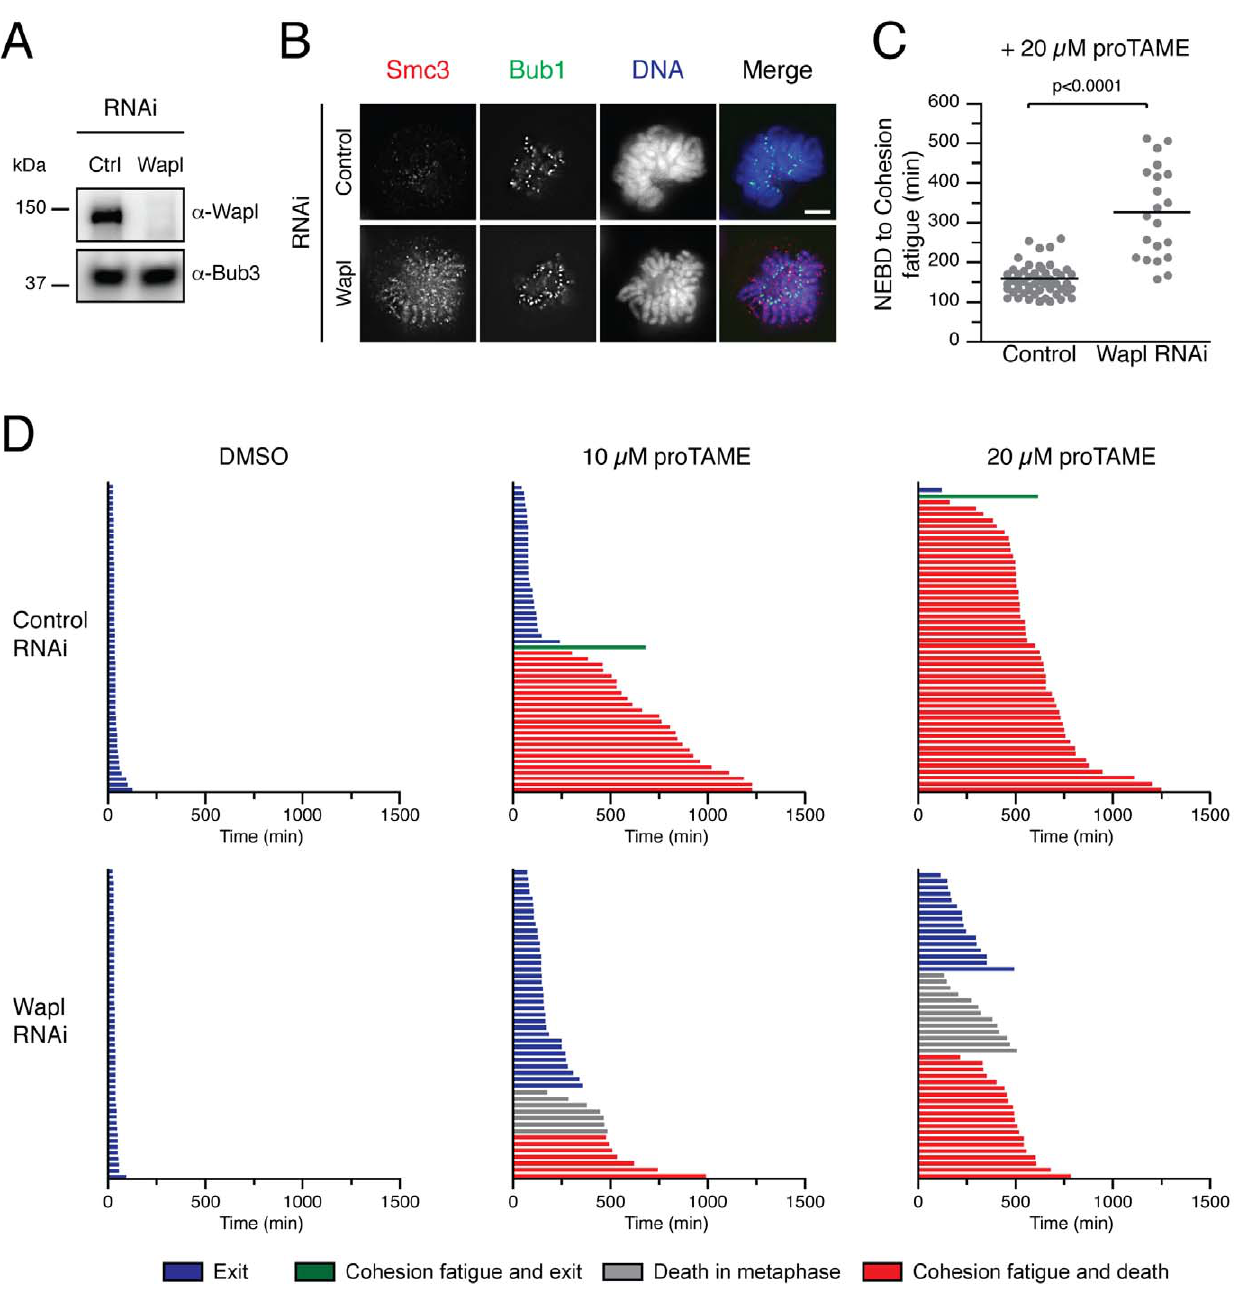
Figure 3. Increasing the level of cohesin on the chromosomes inhibits the mitotic arrest caused by proTAME. ( A ) Immunoblot of HeLa cells treated showing Wapl depletion upon RNAi treatment. Bub3 was used as a loading control. ( B ) Immunofluorescence images of mitotic HeLa cells showing an increased amount of the cohesin subunit Smc3 on the chromosomes upon Wapl depletion. ( C ) Scatter plot of HeLa cells depleted of Wapl and treated with proTAME, showing an increase in the amount of time cells take to undergo cohesion fatigue. P values were calculated using two-tailed Mann-Whitney test. ( D ) Cell fate profiles of HeLa cells depleted of Wapl and treated with different concentrations of proTAME, as described in Fig. 1A. Each line represents an individual cell and different colours represent the different cell fates (see